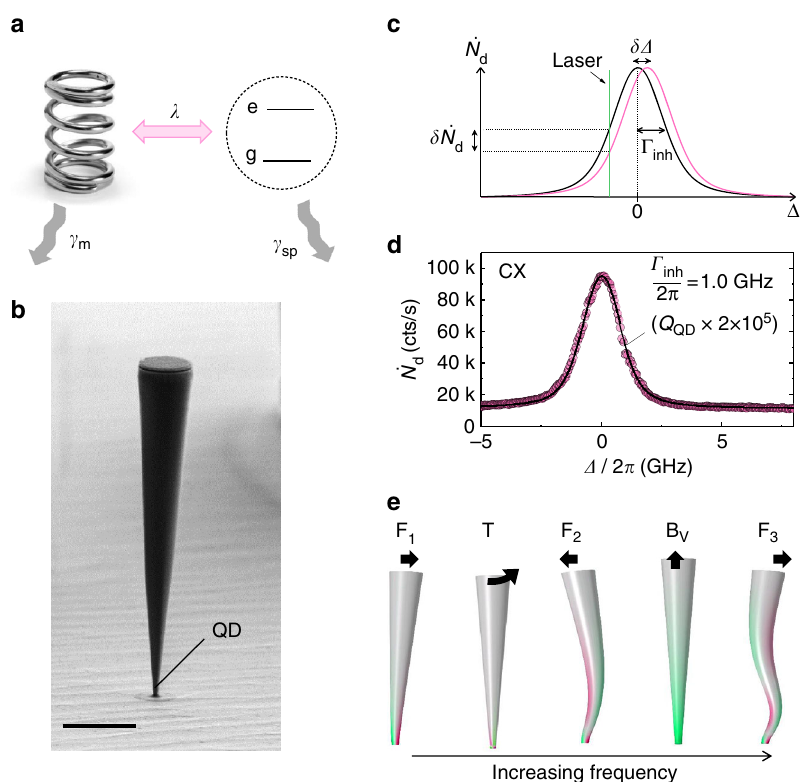
Fig. 1 Quantum dot coupling to a nanowire mechanical resonator. a Sketch of the hybrid system: a mechanical oscillator is coupled to a two-level quantum system. The coupling rate λ ( pink ) competes with the dissipation rates of both components ( grey ): the intrinsic phonon relaxation rate γ m and the spontaneous emission rate of a photon γ sp . b Practical realization: a quantum dot (QD) is embedded close to the bottom of a micrometre-sized mechanical resonator. The coupling originates from strain as the nanowire oscillates. The scale bar corresponds to 2 μ m. c Effect of the coupling: a displacement u of the nanowire produces a shift δΔ in the QD frequency, modifying the detuning between the QD and the laser. Γ inh is the linewidth of the QD, inhomogeneously broadened by spectral fl uctuations. d Resonance fl uorescence signal from the charged exciton (CX) as a function of laser detuning ¼ 1 : 1 GHz. The fi t uses a Voigt pro fi le with a contribution to the linewidth of 0.45 GHz from the Lorentzian ( fl uorescence wavelength: 945.6 nm). Ω R ’ γ sp part, and 0.70 GHz from the Gaussian one. e The mechanical modes: F 1 , F 2 and F 3 correspond to the fi rst, second- and third-order fl exural modes; T to a torsional mode and B v to a vertical breathing mode. The colour map represents the strain along the vertical axis within the trumpet ( green : tensile, pink : compressive). The black arrows represent the displacement of the nanowire ’ s top